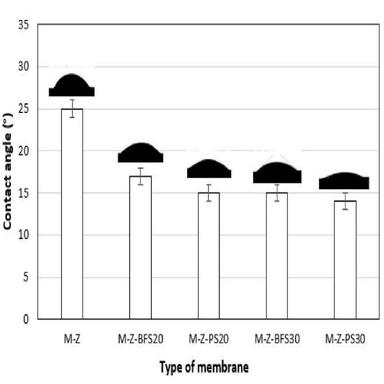
Contact angle of M-Z, M-Z-PS20, M-Z-BFS20, M-Z-BFS30, and M-Z-PS30 membranes.